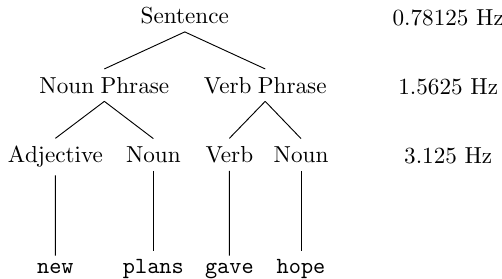
Figure 1. Demonstration of a syntactic tree for an example sentence from 8,9 . The sentence is composed of a noun phrase and a verb phrase, each consisting of two words presented at a rate of 3.125 Hz. The sentence is described using a hierarchical tree that splits the sentence first into a noun phrase and a verb phrase and then into words. This is a particularly simple tree, more complex trees may have more branches. This simple structure is convenient for frequency tagging and the different frequencies corresponding to the three levels of the tree, sentence, phrase and word, have been marked